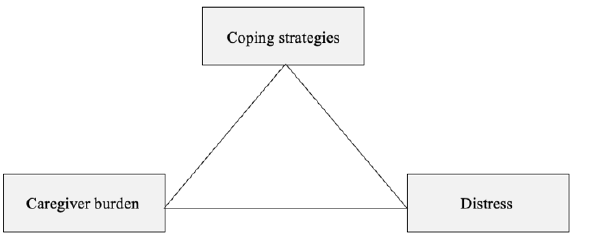
Figure 1. The Theoretical Framework of Caregiver Burden, Coping Strategies and Distress (adapted from Folkman et al. [6].